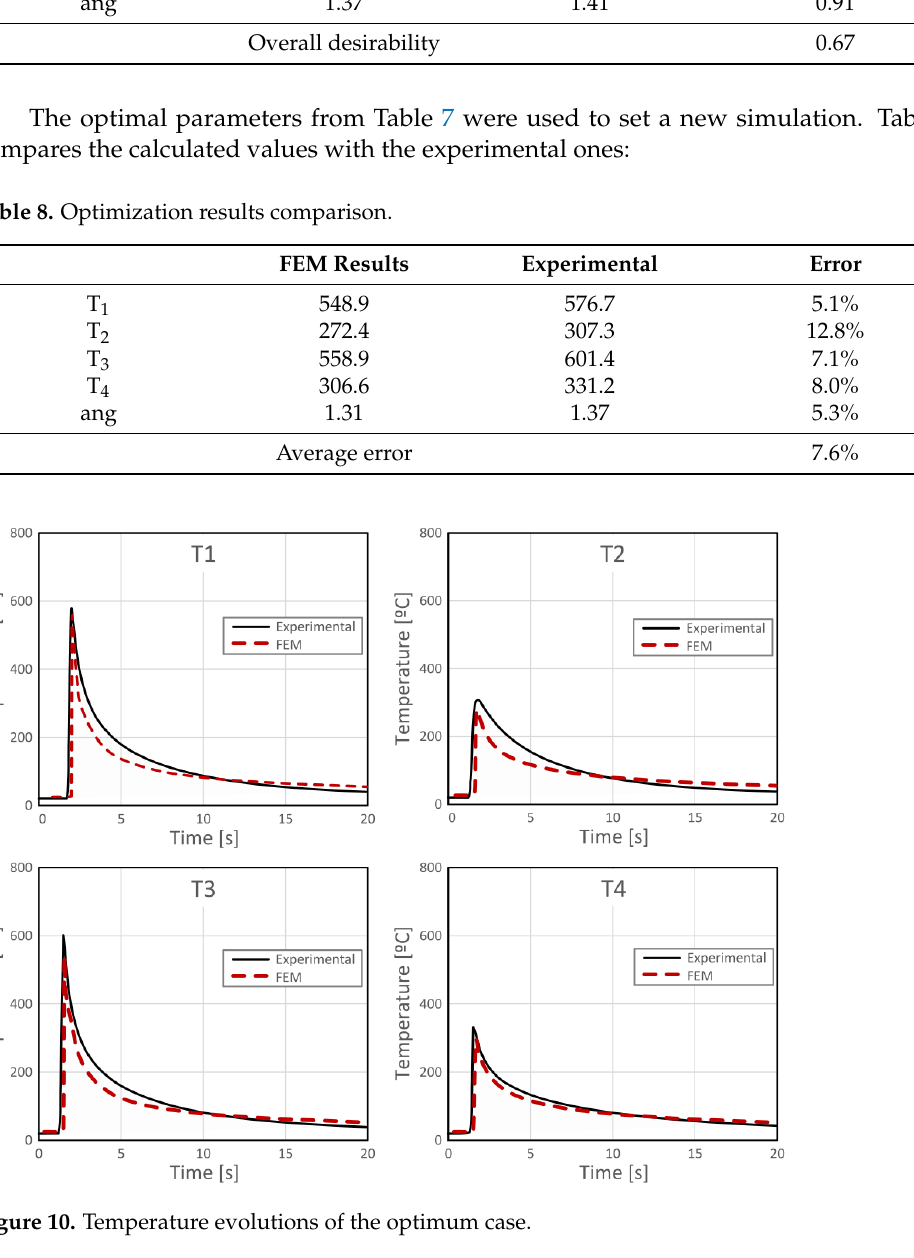
Table 8. Optimization results comparison.